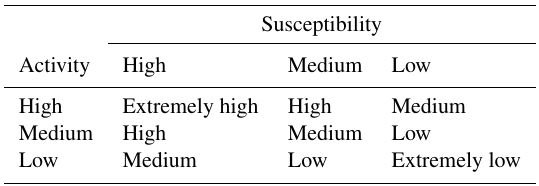
Table 7. Hazard level combined by evaluation of landslide suscep- tibility and activity (Lin, 2017).